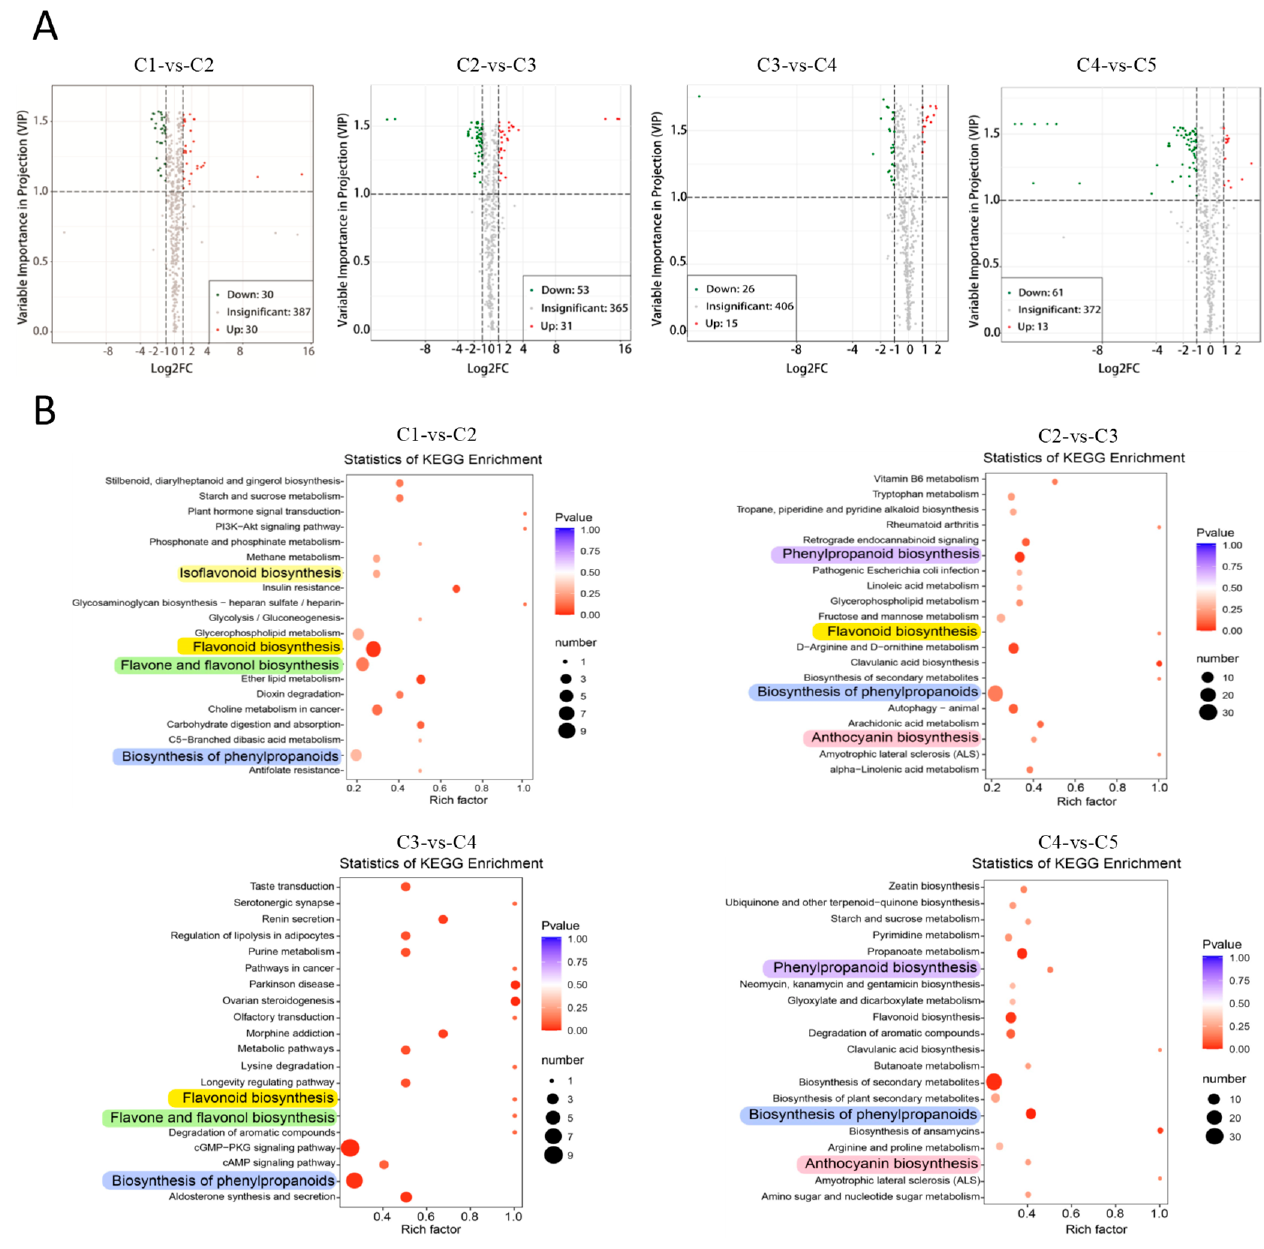
Figure 3. Differential accumulating metabolites for adjacent leaf stages. ( A ) Volcano plots of the identified DMs for adjacent leaf stages, with the red, green, and gray dots showing up-DMs, down- DMs, and insignificant DMs, respectively. ( B ) Top 20 significantly enriched KEGG pathways for adjacent leaf stages. The X -axes indicate the “enrich factor” represented by the ratio of DMs numbers to total annotated compound numbers of each pathway. Y -axes on the left represents KEGG pathways. The area of a circle represents the DM number. The KEGG pathways associated with biosynthesis of phenolics were highlighted.